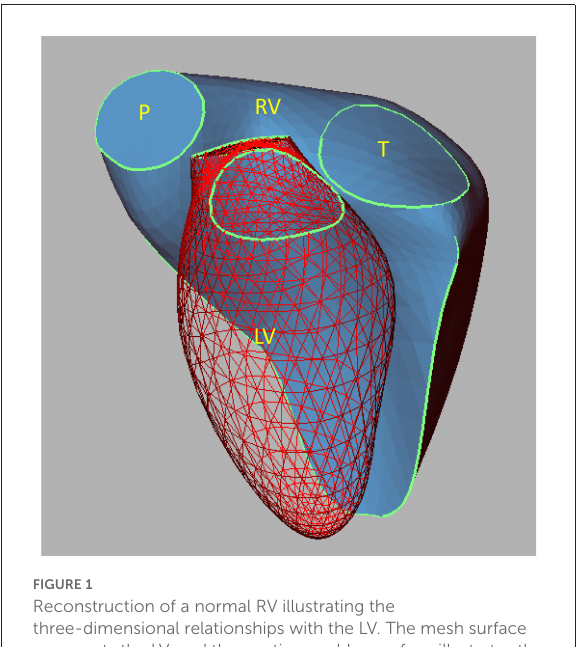
FIGURE1 Reconstruction of a normal RV illustrating the three-dimensional relationships with the LV. The mesh surface represents the LV, and the continuous blue surface illustrates the RV. LV, left ventricle; P, pulmonary valve; RV, right ventricle; T, tricuspid valve. Reproduced from Sheehan and Redington (19).